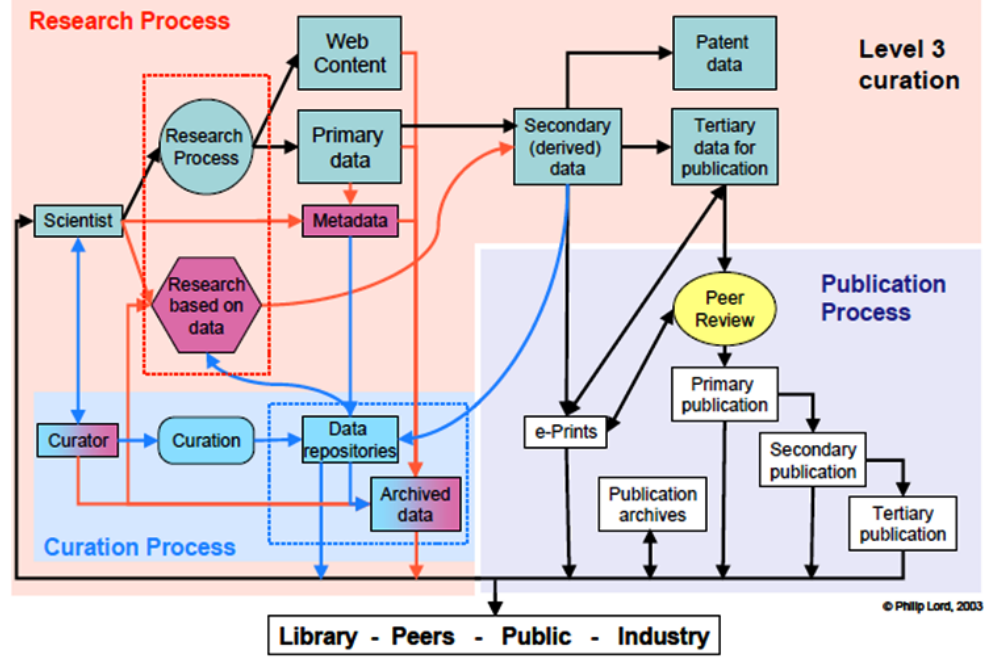
Figure 2. Three-level data curation model proposed for e-Science specifications. Image source: Figure 10 of